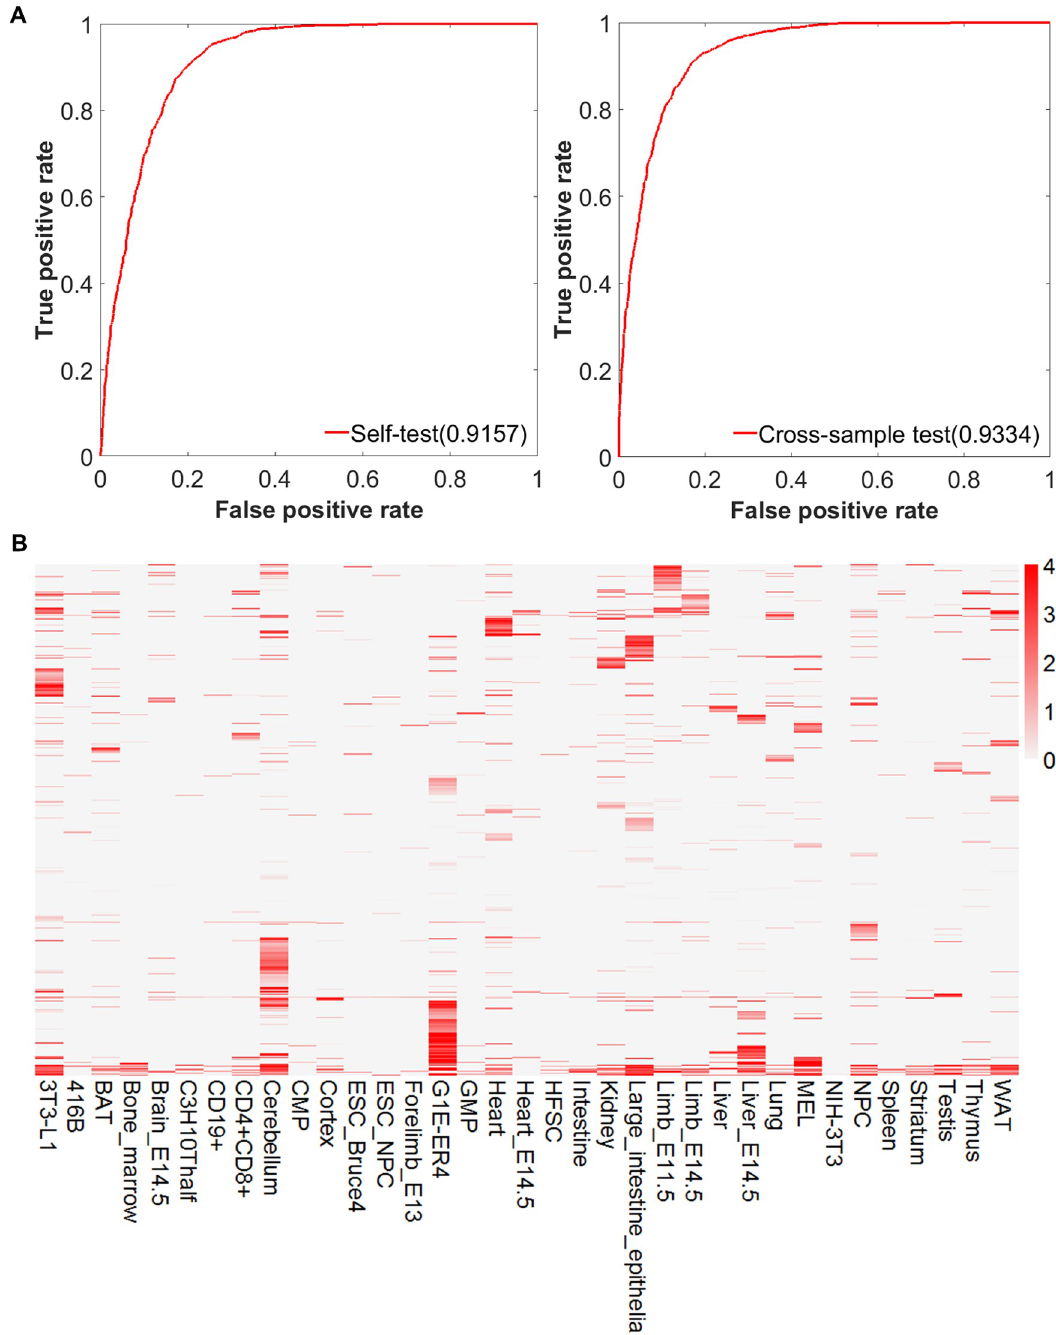
Fig 9. Application of EAGLE to mouse tissue/cells. (A) Performance of EAGLE model in the mouse by self-testing and cross- sample test. (B) Enhancer-target relationships across 35 representative cell types in the mouse. The EAGLE model in the mouse was trained in the lung. In the heatmap, each row represents an enhancer-target interaction, while each column is one particular cell type. The color represents the prediction confidence score for this interaction. On average, 95,723 relationships were identified in each cell type. Majority of the relationships were